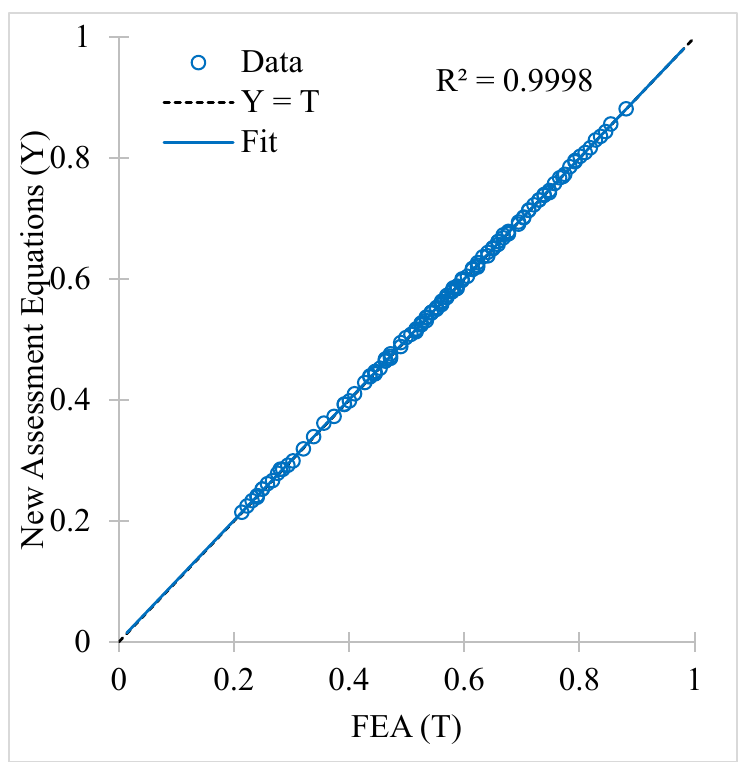
Figure 14 . Regression plot of normalized failure pressure predicted by the new assessment equations against FEA results.